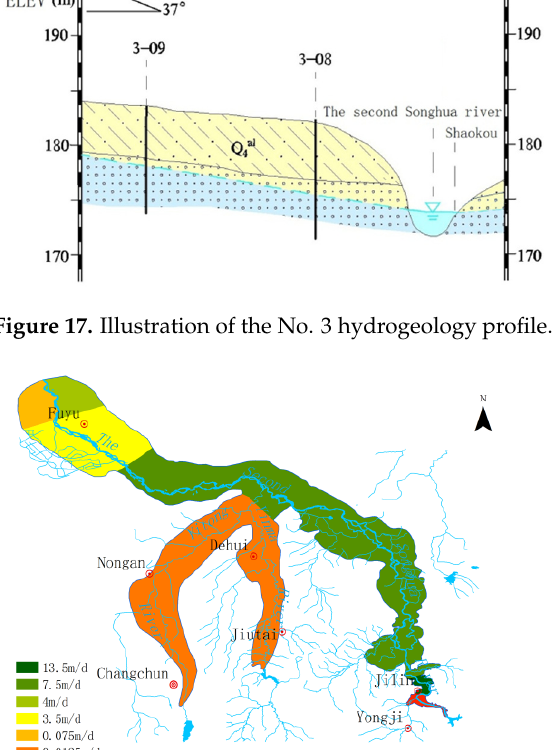
Figure 18. Distribution of riverbed permeability.